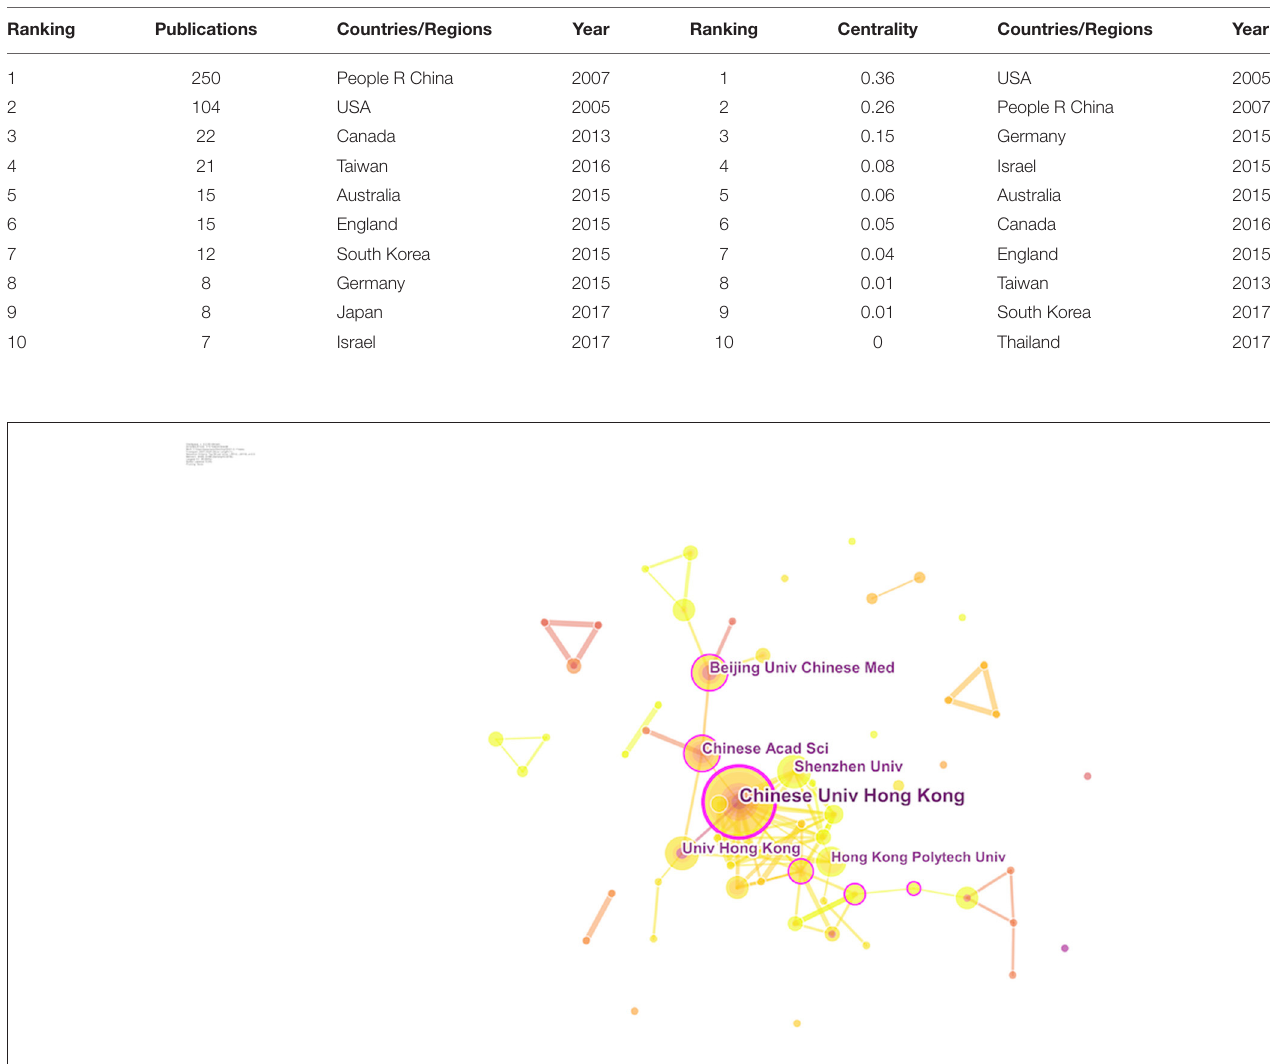
FIGURE 3 | Cooperation map of institutions from 2001 to 2020.